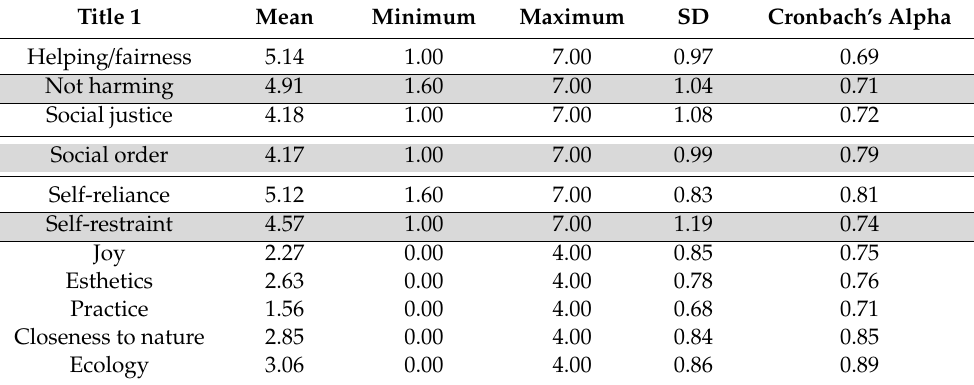
Table 1. Descriptive statistics and reliabilities of all variables investigated.